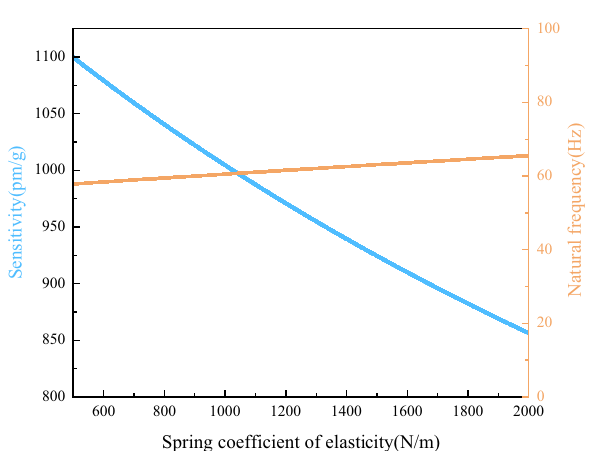
Figure 5. Effect of k 2 on S and f .